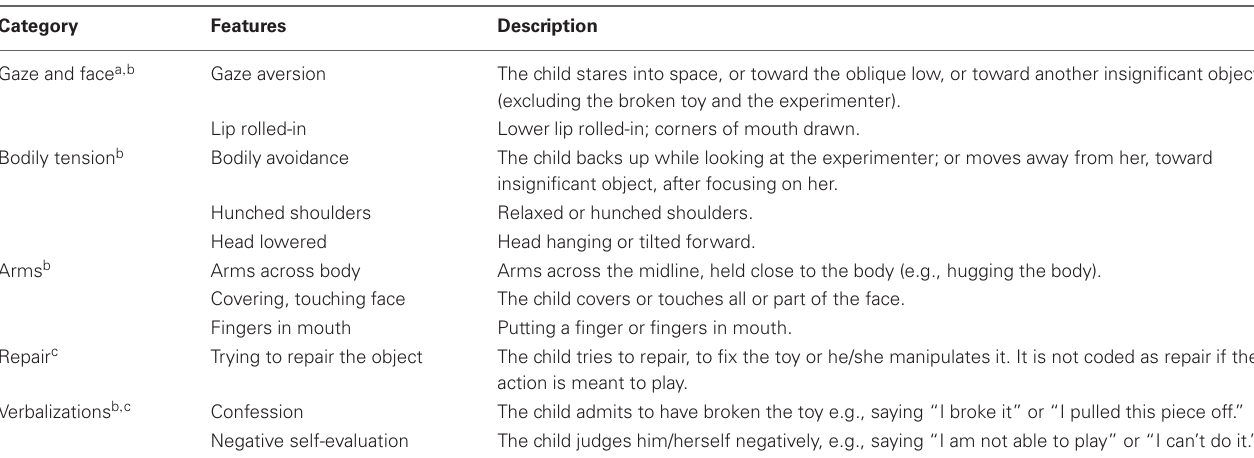
Table 1 | Expressive features coded for the scoring of child